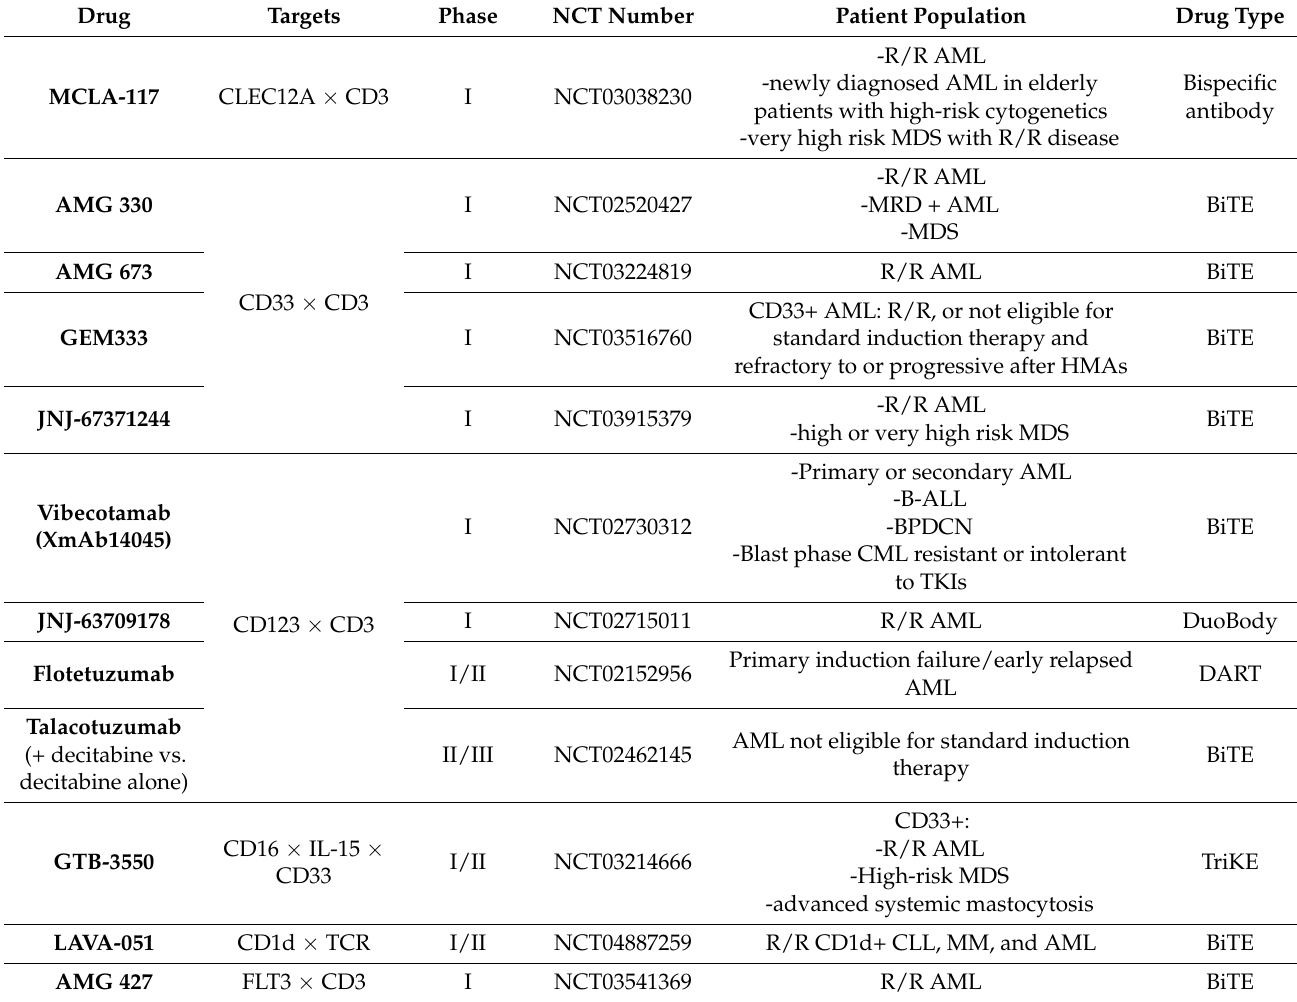
Table 2. Recent clinical trials of multivalent antibodies for AML. All trials are for adults only. TriKE, tri-specific killer cell engager. R/R, relapsed/refractory. MRD, minimal residual disease. DART, dual-affinity retargeting antibody. Drug Targets Phase NCT Number Patient Population Drug Type MCLA-117